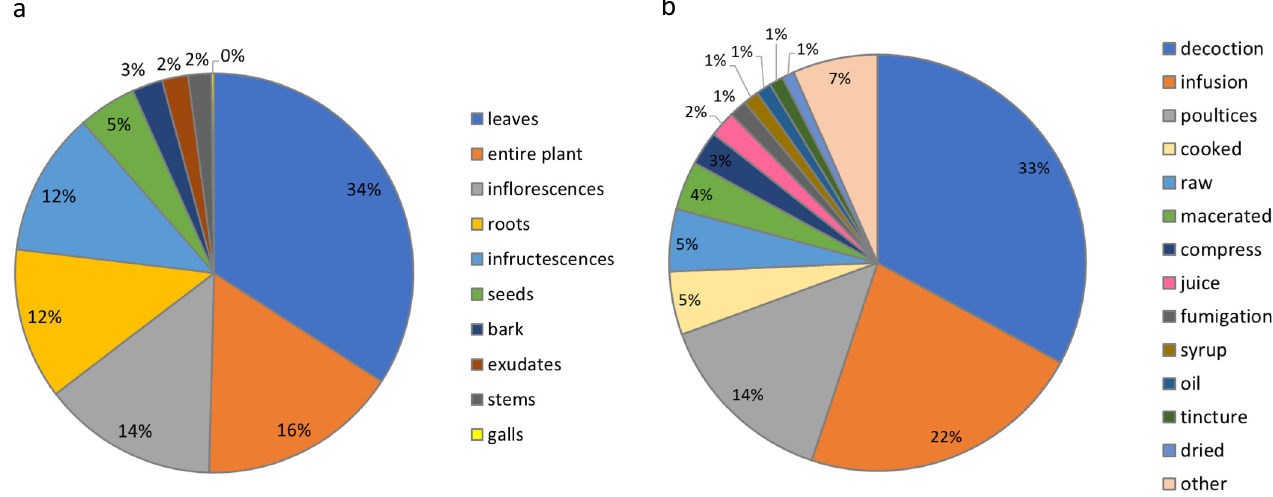
Figure 2. Plant parts used for medicinal preparations. ( a ) Type of remedy preparations and applications. ( b ) Other preparations include liqueur, ointment, crushed, milled, chewed, jam, eaten, cooking water, powdered, oleolite, washes, rubbed, extract, pulped, distilled, smoked, sniffed, and kept in pockets. The classifications used were based on standardized descriptors as reported by Cook [91] .